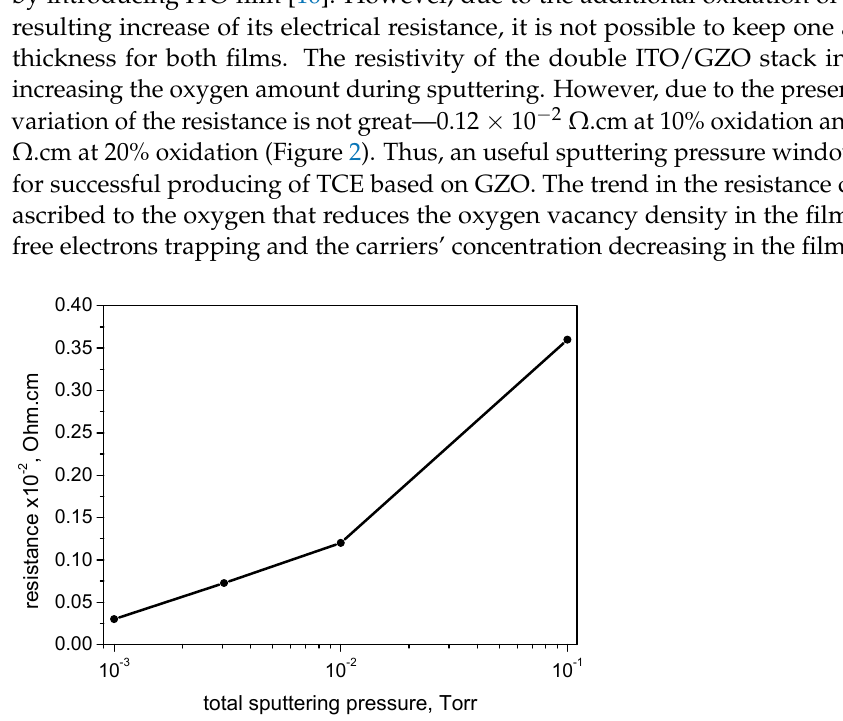
5 of 12 Figure 1. Refractive index of GZO sputtered at different total sputtering pressures due to addi- tional target oxidation: ( a ) in the IR region; ( b ) in the whole spectrum range from UV to NIR.